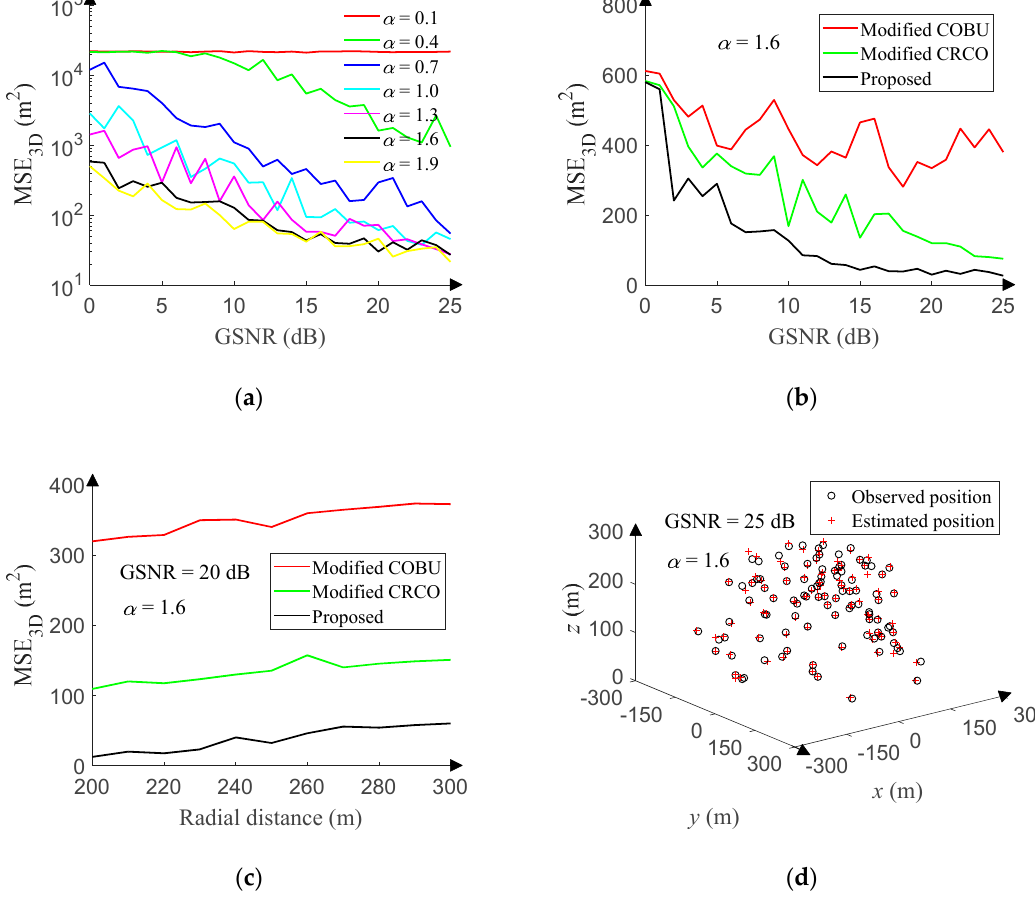
Figure 16. 3D-DOA estimation performance in non-Gaussian noise. ( a ) MSE versus GSNR. ( b ) MSE versus GSNR. ( c ) MSE versus radial distance. ( d ) Response of the proposed method.